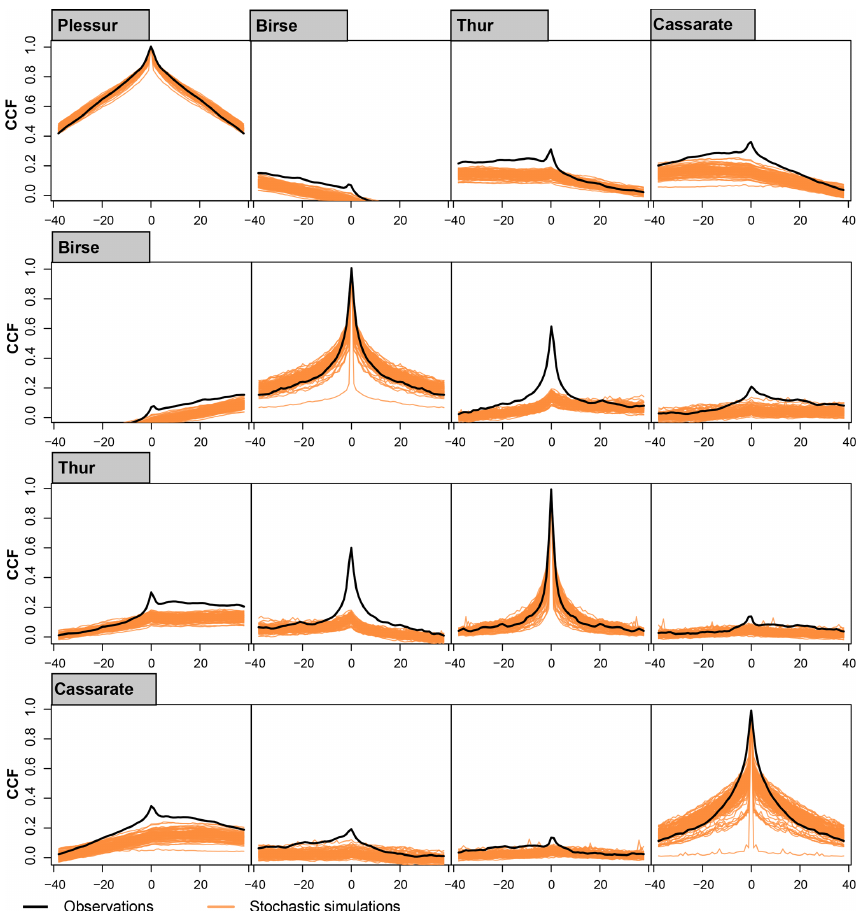
Figure 6. Cross-correlation function (CCF) of observed (black line) and simulated (orange lines) daily streamflow for pairs of stations at Plessur, Birse, Thur, and